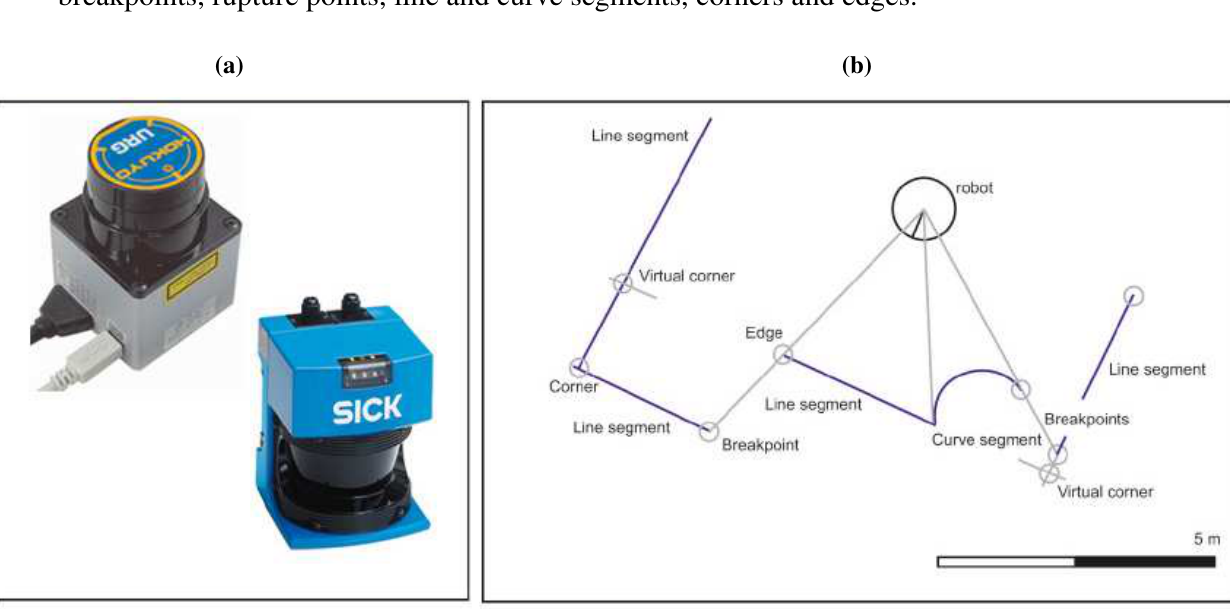
Figure 1. (a) Two laser range sensors widely used in Robotic: a LMS200 from SICK and a HOKUYO URG-04LX. (b) Natural landmarks detected and characterized in this work: breakpoints, rupture points, line and curve segments, corners and